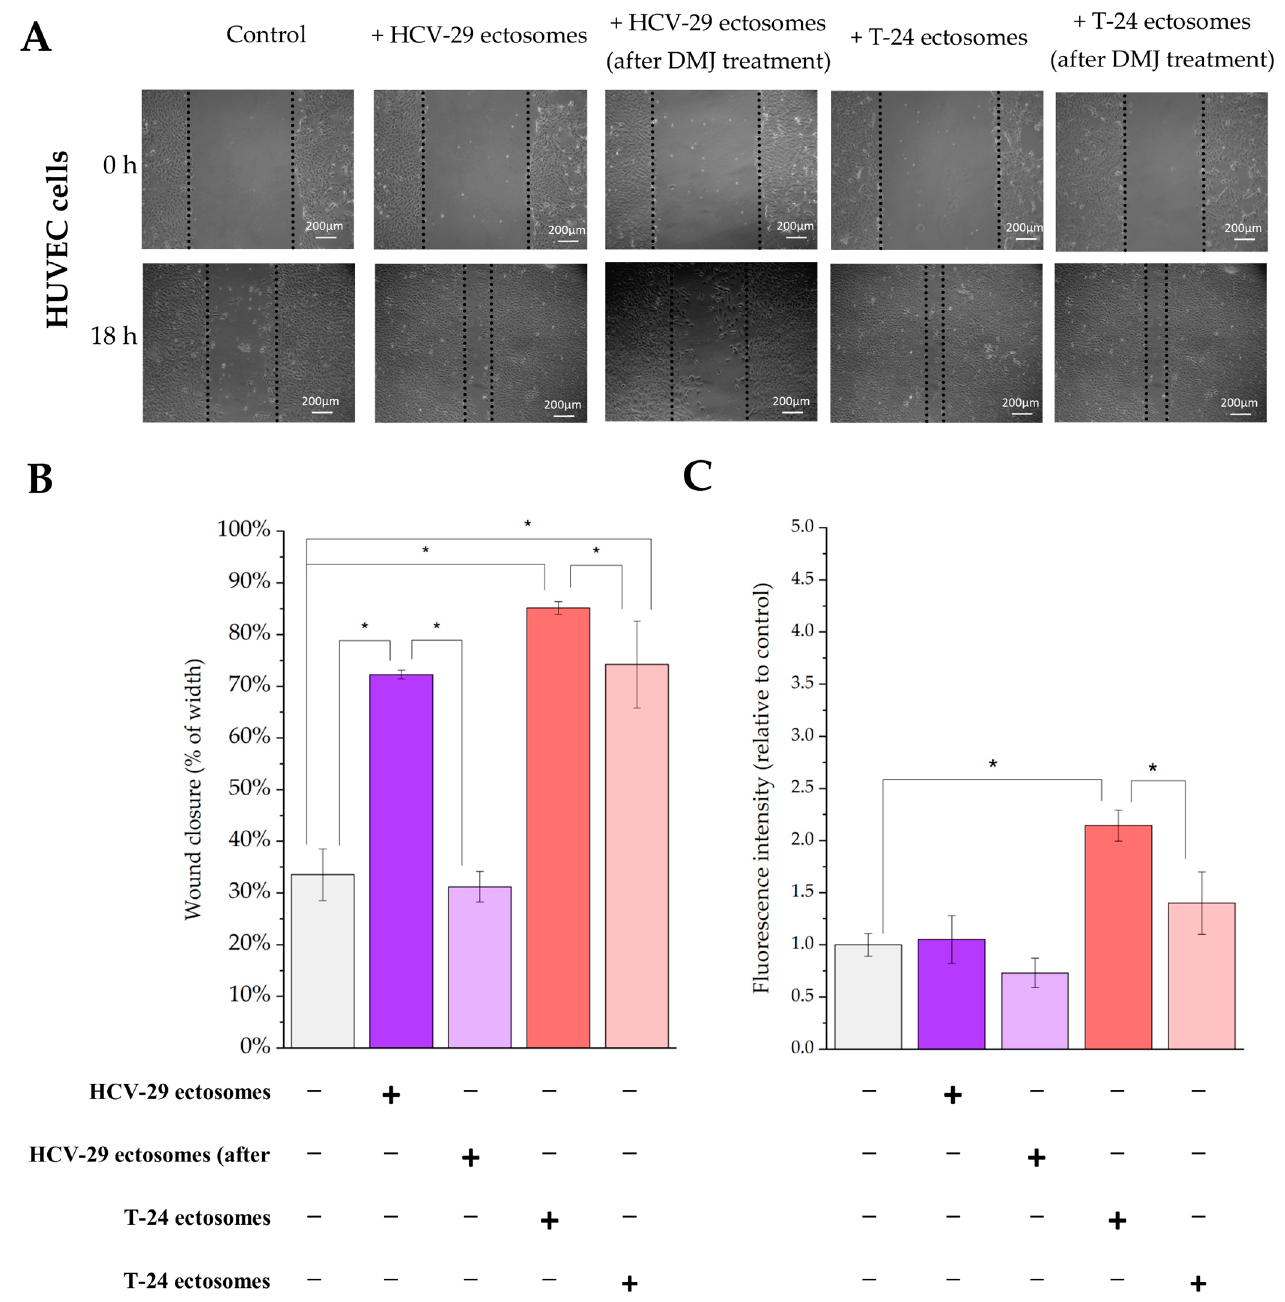
Figure 17. Effect of incubation of endothelial HUVEC cells of with ectosomes released by HCV-29 normal ureter epithelial cells and T-24 urothelial bladder carcinoma cells without or after DMJ treatment on cell viability and motility. Wound healing assay and Alamar blue assays was performed after 18 h of incubation with ectosomes. ( A ). Representative images from wound healing assay were taken at 0 h and at 18 h. ( B ). Graph presenting the percentage rate of wound closure calculated from three repetitions. ( C ). Graph presenting fluorescence intesity measeured in Alamar blue assay relative to control. “*” denotes statistically significant differences (Tukey’s post-hoc test, p -value < 0.05).